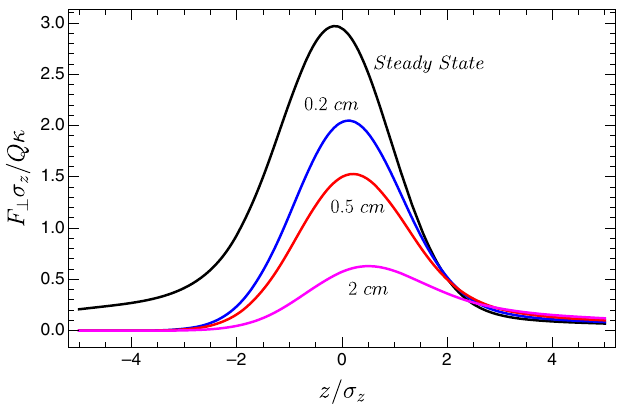
FIG. 5. Transient transverse force on the axis of the beam after the exit from the bend. The numbers near each curve show the distance from the